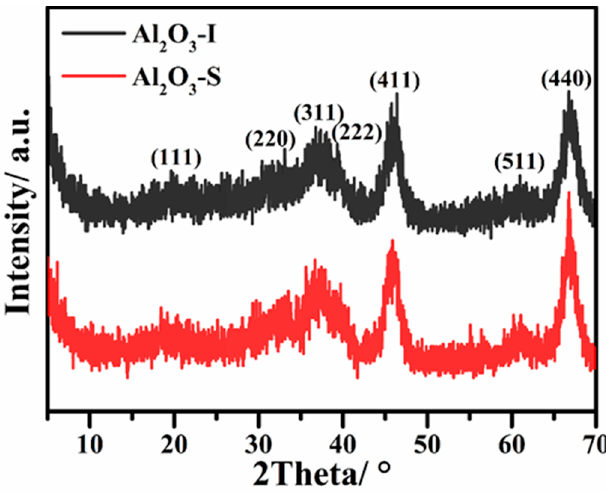
Figure 5. Powder XRD patterns of Al 2 O 3 -I and Al 2 O 3 -S ground powder.